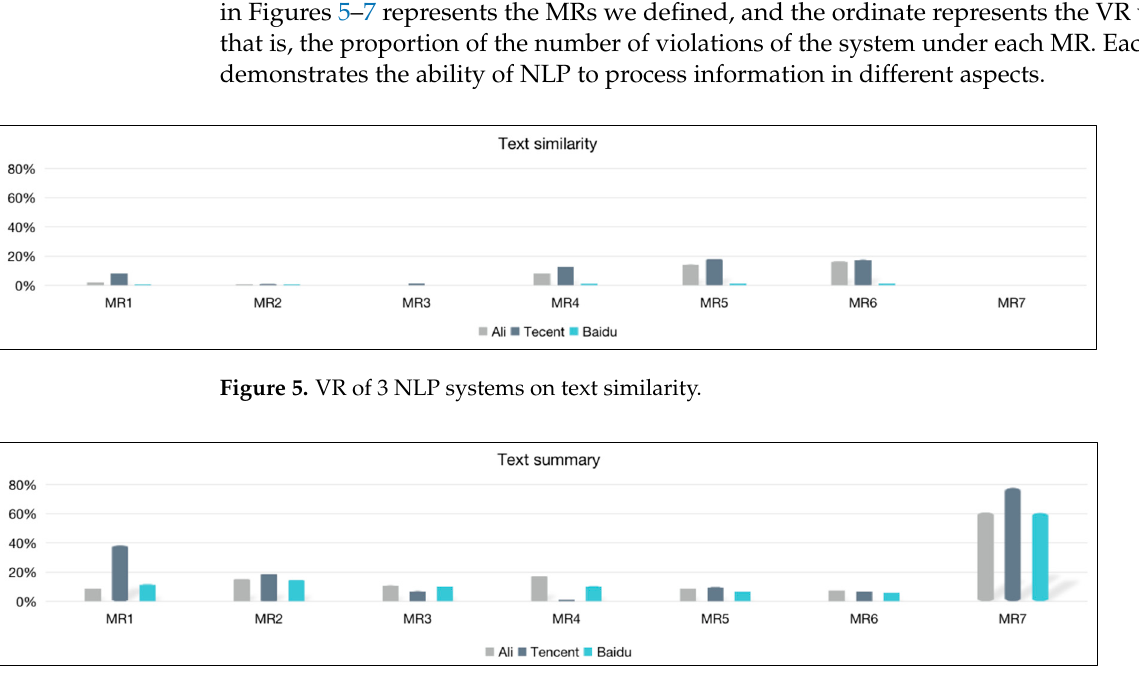
Figure 6. VR of 3 NLP systems on text summarization.